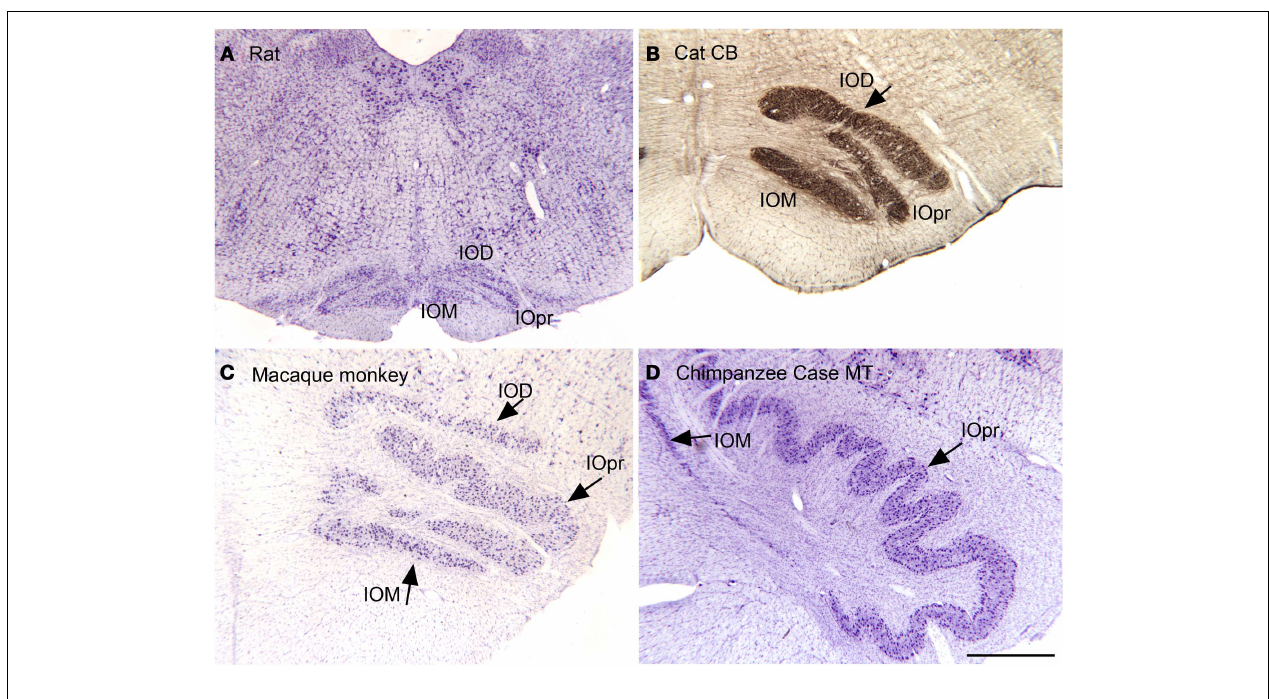
IOM, medial nucleus of the inferior olive; IOpr, principal nucleus of the inferior olive. All images are at the same magnification. Scale bar